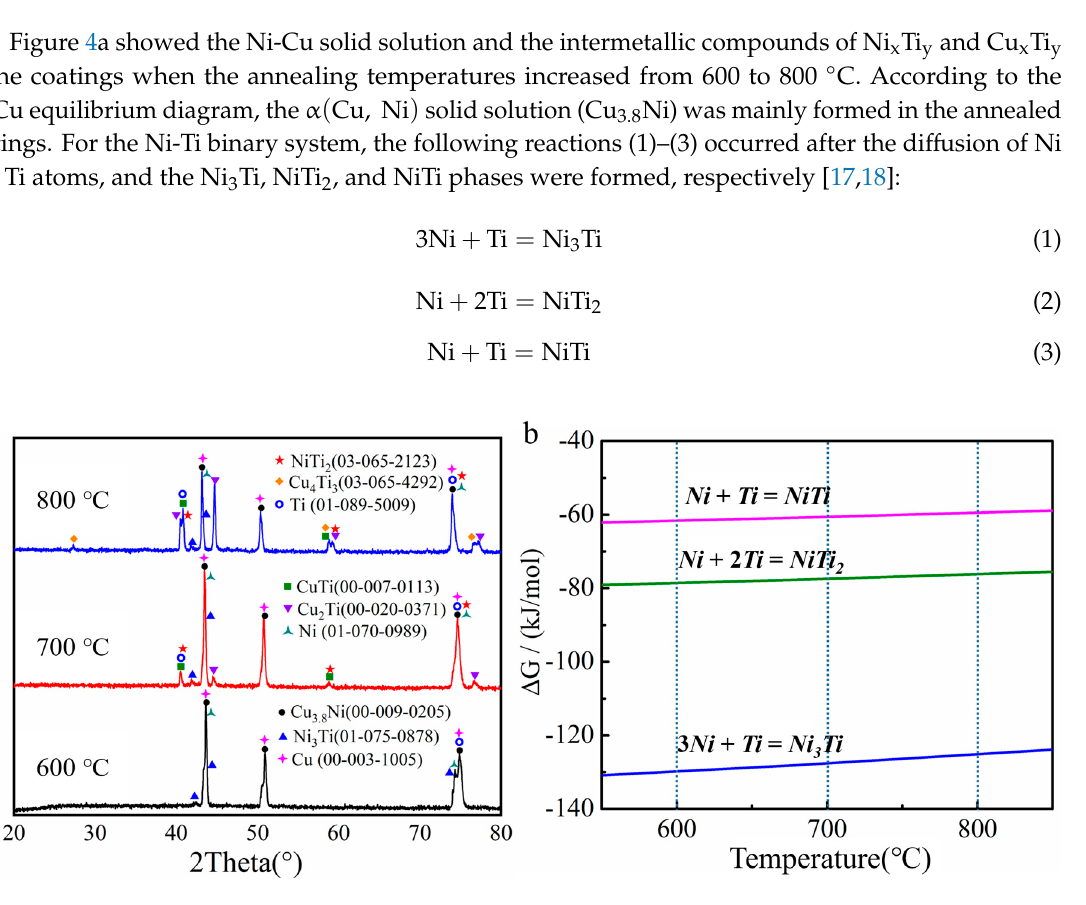
Figure 4. Phases transitions of the Ni / Cu / Ni coatings after annealing at various temperatures: ( a ) surface XRD images and ( b ) Gibbs free energy of the Ni-Ti reaction.